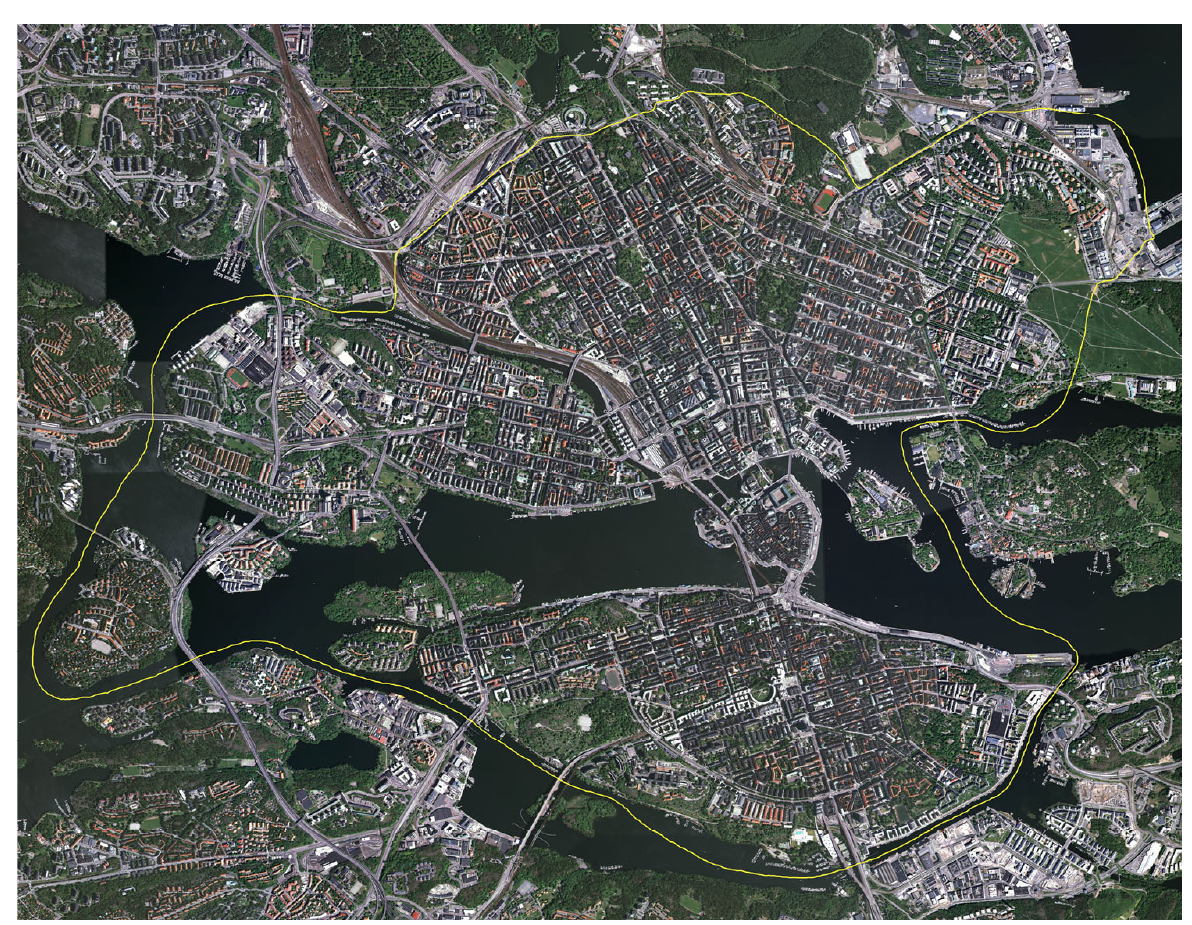
Figure 4. Aerial view of Stockholm in 2005. The area inside the yellow line demarcates the inner urban study area according to our geographical division of the city. North is at the top of the image. (Copyright: Lantmäteriverket, Gävle, Sweden, 2011; Permission 81055230).